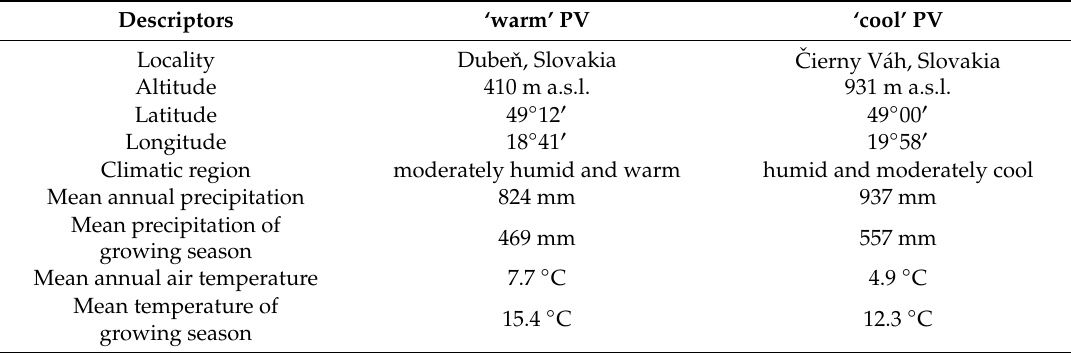
Table 1. Geographical and climatic descriptions of the studied provenances of Norway spruce. The climatic data were obtained from the high-resolution interpolated climate database WorldClim and representthemeanvaluesofdescriptorswithintheperiodof1970–2000ataresolutionof30”seconds[26]. Di ff erent spruce provenances are signed as ‘warm’ PV (‘warm’ provenance from ‘outside the natural range of Norway spruce’) and ‘cool’ PV (‘cool’ provenance from ‘spruce